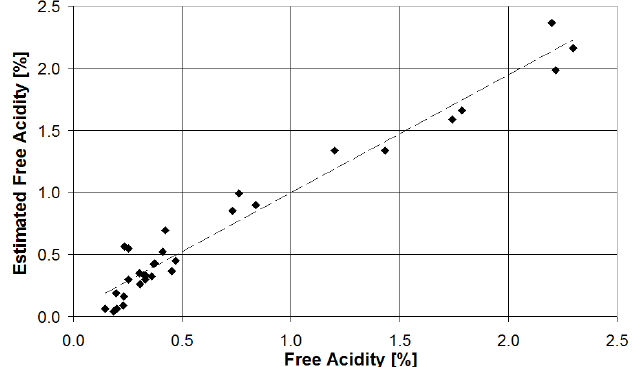
Figure 3. Scatter plot of the emulsion electrical conductance measured at 23.5 °C using the HAS reagent vs. free acidity for the subset of olive oil samples featuring a peroxide index < 20 meq O 2 /kg oil.